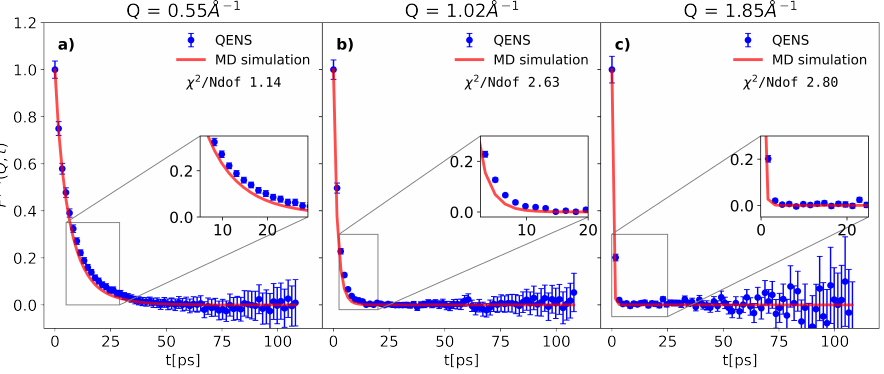
Figure 4. The symmetrized, normalised and deconvolved intermediate scattering function, F ( + ) ( Q , t ), for the QENS data and the MD simulation of bulk-water at 300 K , at three di ff erent